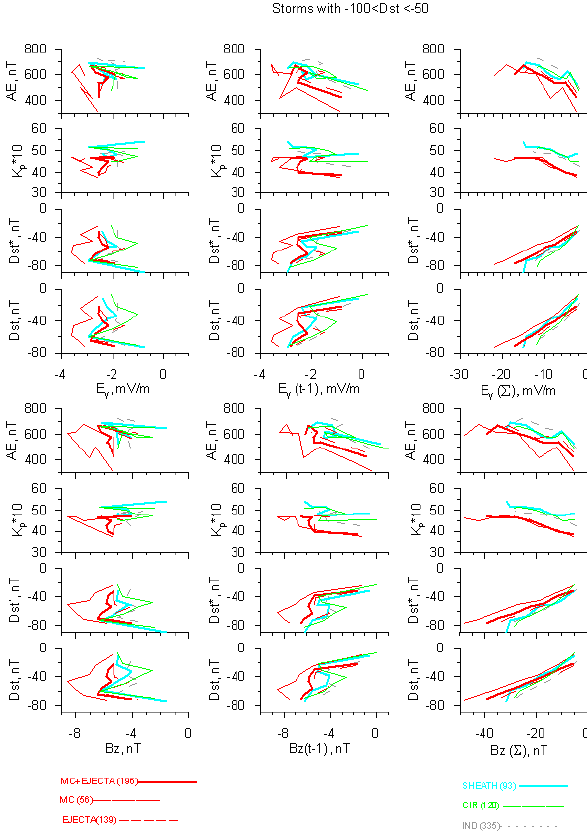
Fig. 7. Time evolution of Dst,Dst ∗ ,Kp and AE indices during time evolution of Bz and Ey for time interval of ”0” - ”6” using Fig. 8. The same as in Fig. 7 for moderate storms with Fig. 8. The same as in Fig.7 for moderate storms with -100 − 100 < Dst < − 50nT. 3 procedures (see text): (1. Left column) simultaneous measure- < Dst < -50 nT. ments, (2. Second column) 1-h displaced measurements, and (3. Right column) dependence of indices on integral value of sources.